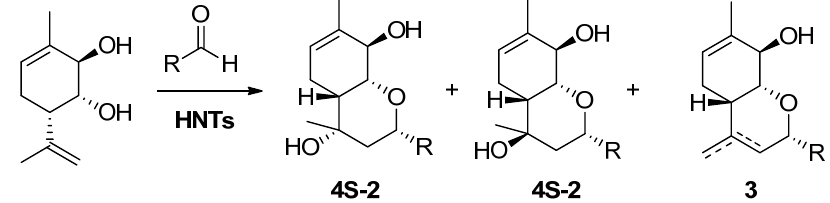
Figure 4. Condensation reaction of p ‐ menta ‐ 1,8 ‐ diene ‐ 5,6 ‐ diol 1 with